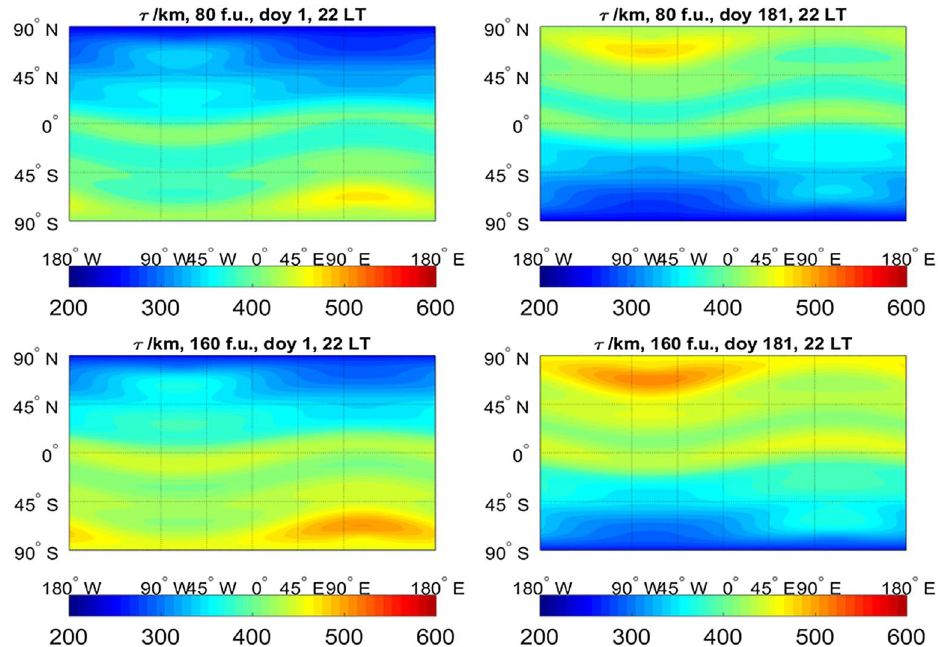
Fig. 20. Global maps of NSTM at 22 LT for days 1 (left) and 181 (right) under low and high solar activity conditions ( F 10 = 80 and F 10 = 160, respectively).